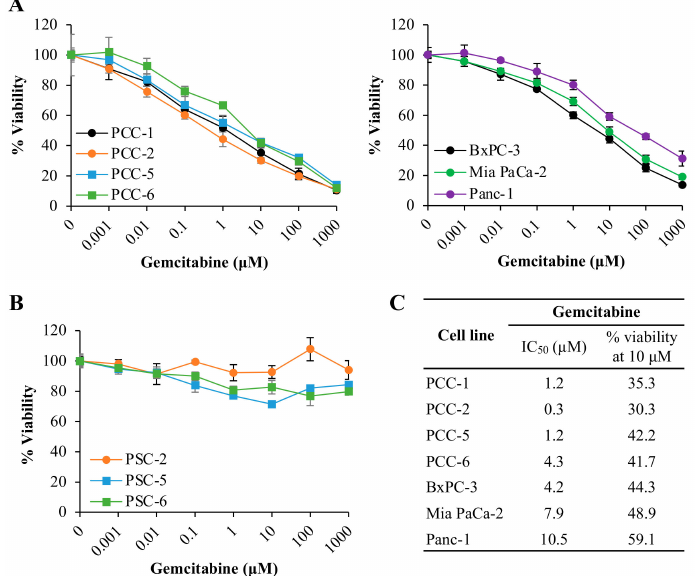
Figure 1. Assessment of gemcitabine-induced cytotoxicity. Human PDAC-derived primary cultures